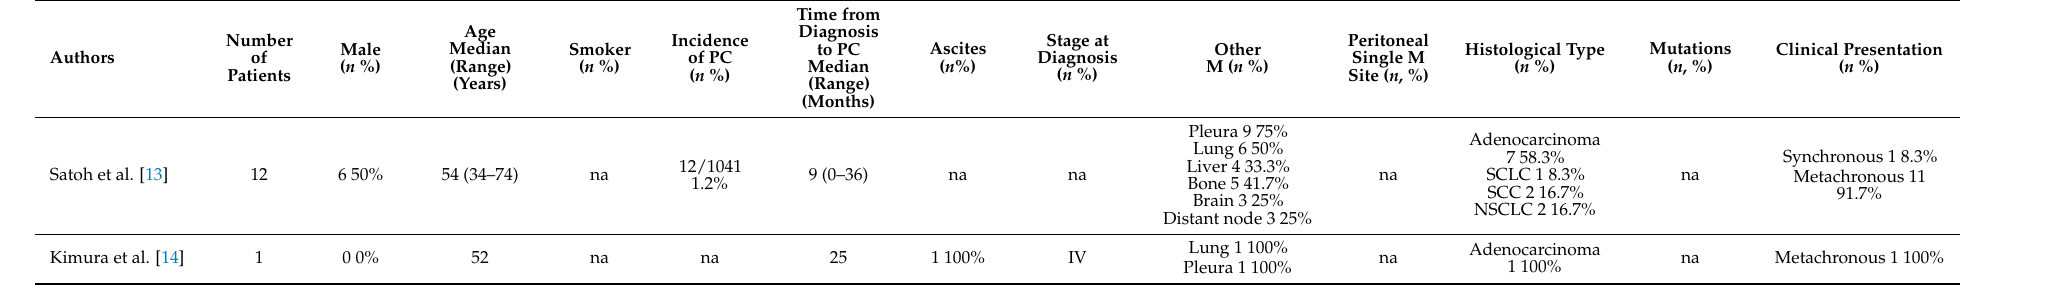
Table 2. Baseline characteristics of peritoneal carcinosis from lung cancer